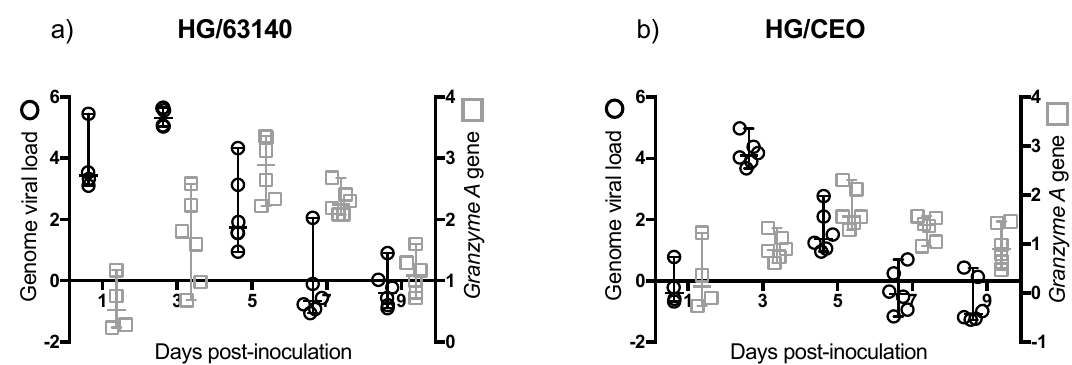
Figure 7. Transcription of the Granzyme A gene in relation to genome viral load in the Harderian gland (HG). Individual median fold change (log 10 2 − ∆∆ C t ) transcription of the Granzyme A gene in the HG of 63140 ( a ) and CEO ( b ) groups are presented in the y right axis (open square), with the median represented as the horizontal line and the 95% confident interval as the vertical line. Individual mean genome load (log 10 2 − ∆∆ C t ) in the CALT of 63140 ( a ) and CEO ( b ) groups are presented in the y left axis (open circle), with the mean represented by the horizontal line and the standard deviation as the vertical line.